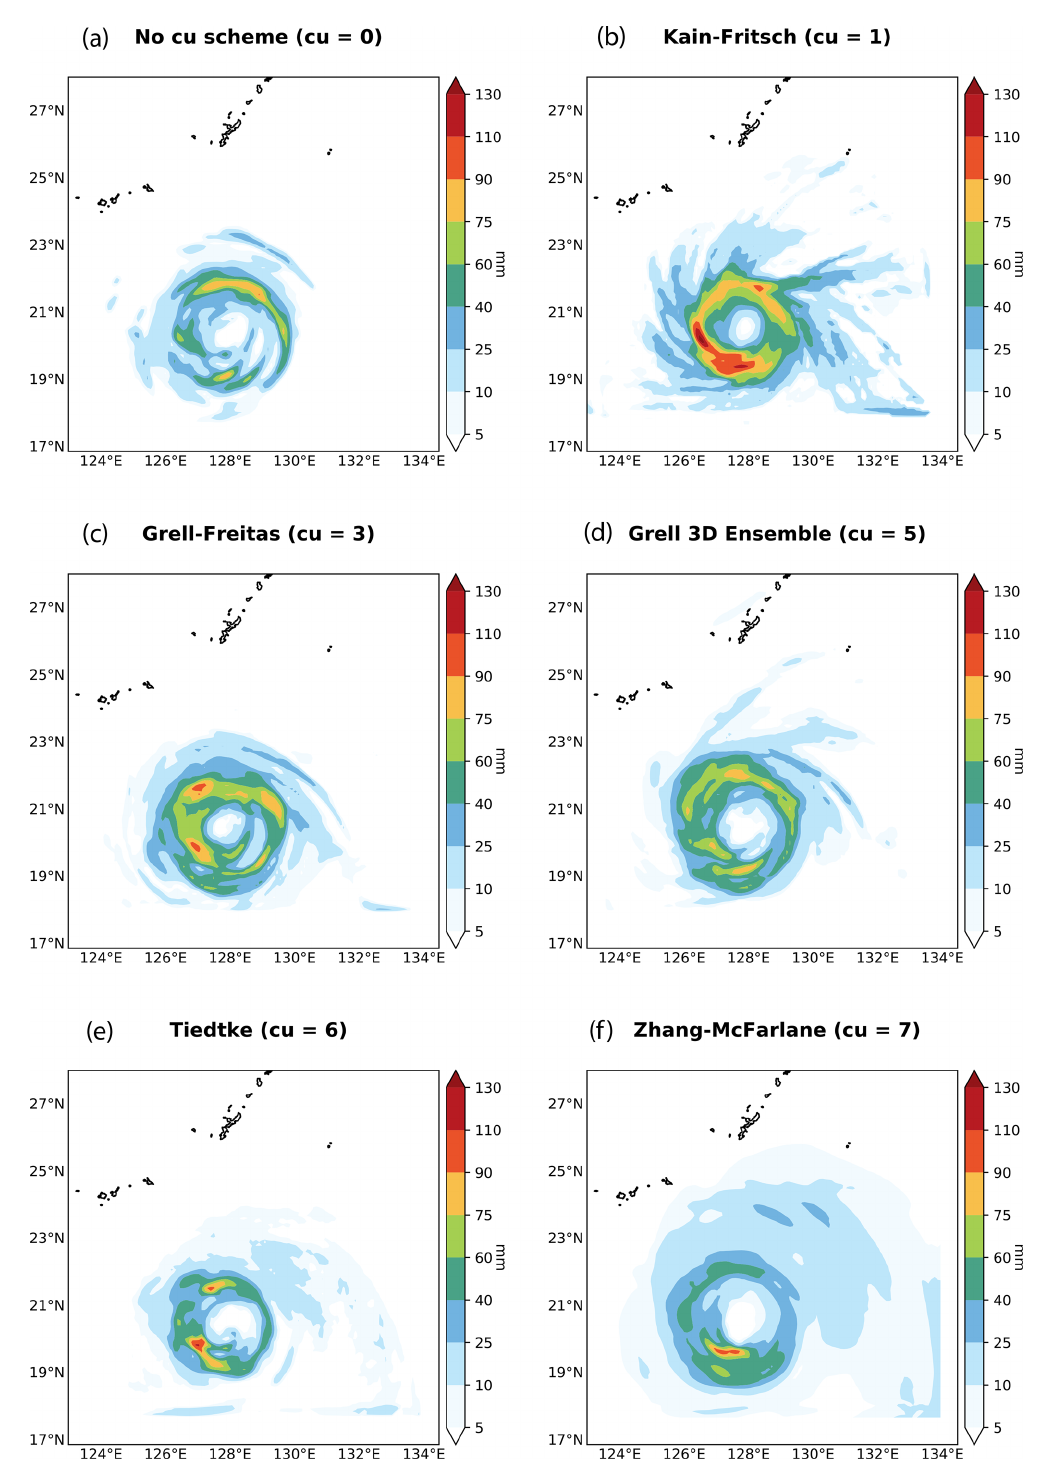
Figure 2. Simulated 6h accumulated surface liquid precipitation for Typhoon Megi without using a CP (a) and using five different CPs in the WRF model. The accumulated precipitation includes cumulus, shallow cumulus, and grid-scale rain. The simulations start on 25 Septem- ber 2016 at 18:00UTC. The domain is located over the Philippine Sea with a horizontal grid size of 10km. Radiation scheme: RRTMG short- wave and longwave schemes, boundary layer scheme: Mellor–Yamada–Janji´c scheme, microphysics scheme: NSSL two-moment scheme, land surface option: unified Noah land surface model, surface layer option: eta similarity scheme. Spinning time: 24h. GFS data were used to perform these simulations. The typhoon was not